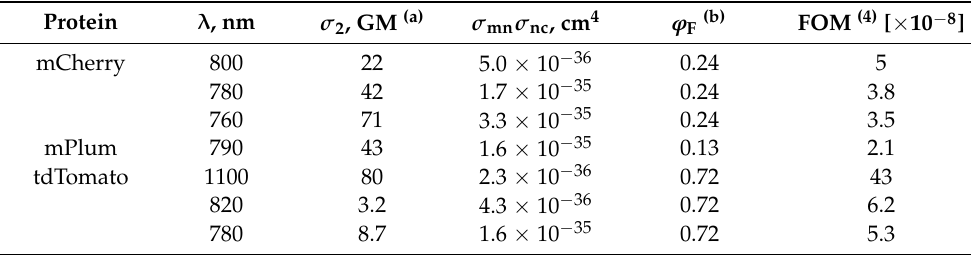
Table 5. Figure of Merit for TPLM applications of FPs showing fourth-order power dependence of multiphoton bleaching rate.